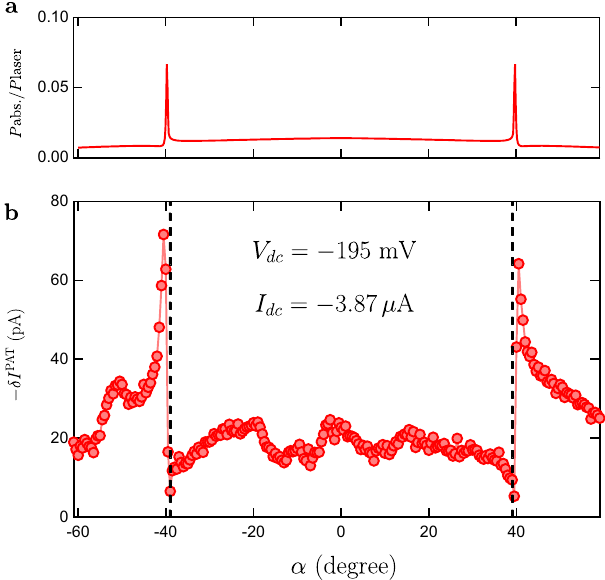
Fig. 2 Angle dependence of the surface plasmon polariton resonance. a Theoretical value of the ratio between the absorbed power P abs and the laser power P laser as a function of the angle α . b Detection of the suface plasmon resonance by measuring the photon-assisted current at room